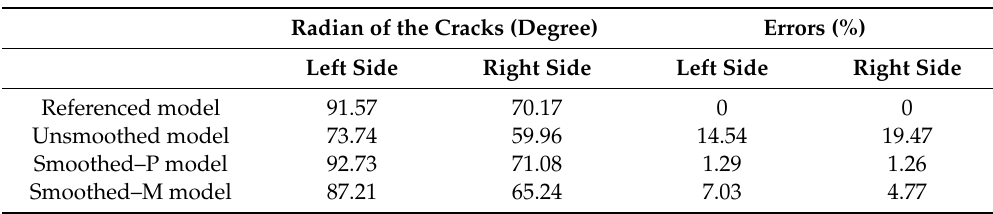
Table 2. Radians of the debonding cracks.